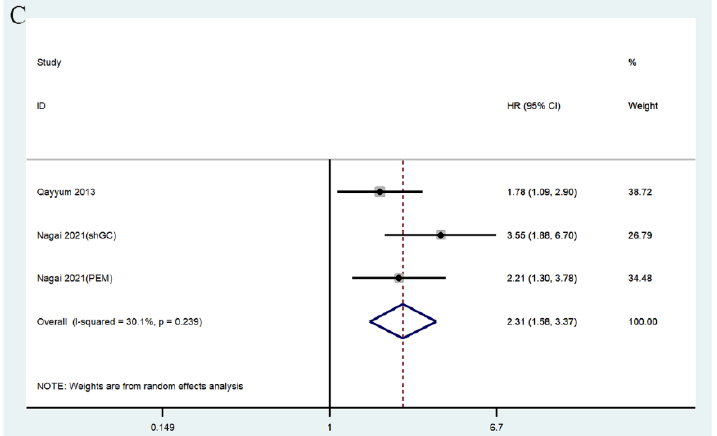
Figure 6. Forest plots of relationship between mGPS and CSS in patients with urothelial carcinoma: ( A ) mGPS 1 vs. 0; ( B ) mGPS 2 vs. 0; ( C ) mGPS high vs. low [17,22,25,27,28,31,32].